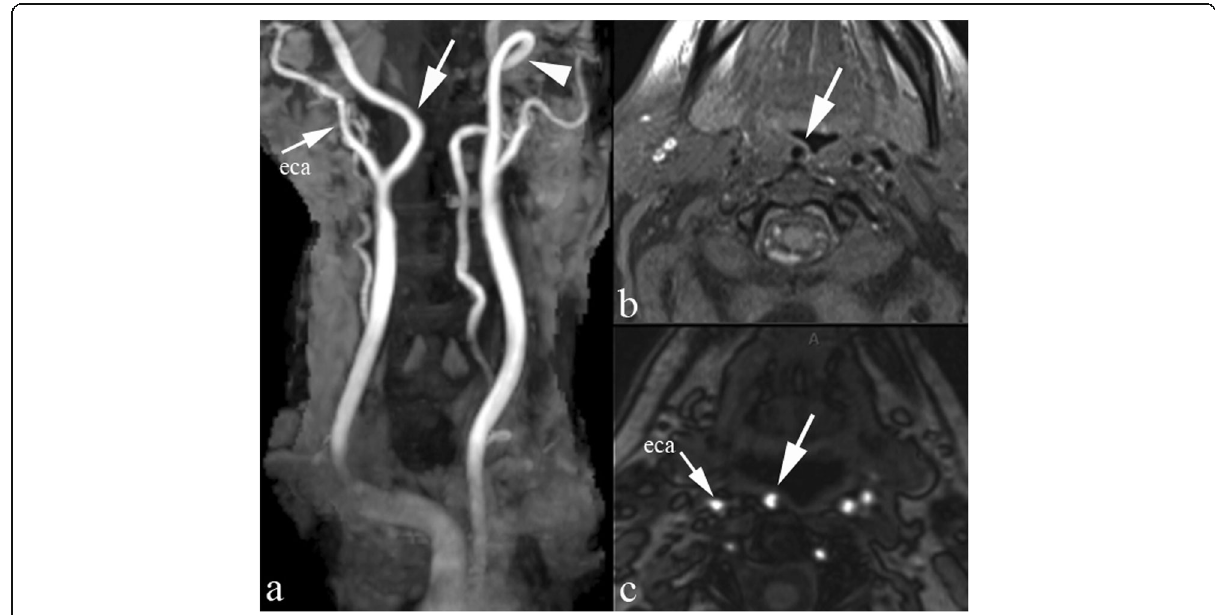
Fig. 11 Retropharyngeal carotid artery . MRI 3D TOF, thick maximum intensity projection (MIP) reconstruction on coronal plane ( a ) and native axial partition ( c ); fat suppressed axial SE T1 with contrast administration ( b ). The right ICA (large arrows) bends medially reaching the midline behind the posterior oropharyngeal wall. Coiling of the left ICA (arrowhead). eca external carotid artery